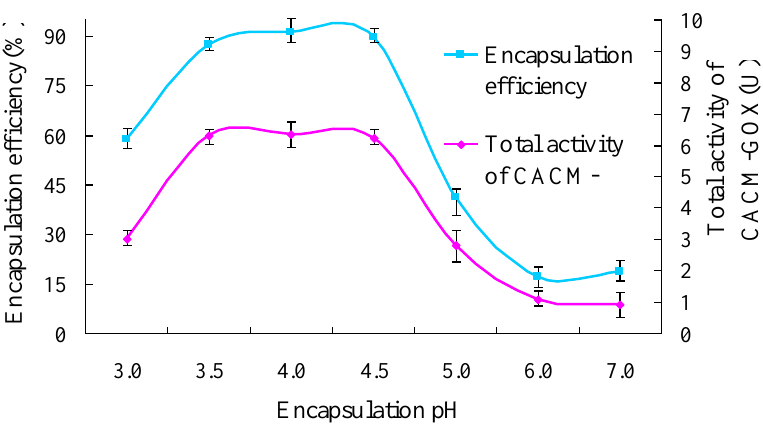
Figure 5. Effect of encapsulation pH on total activity of CACM-GOX and encapsulation